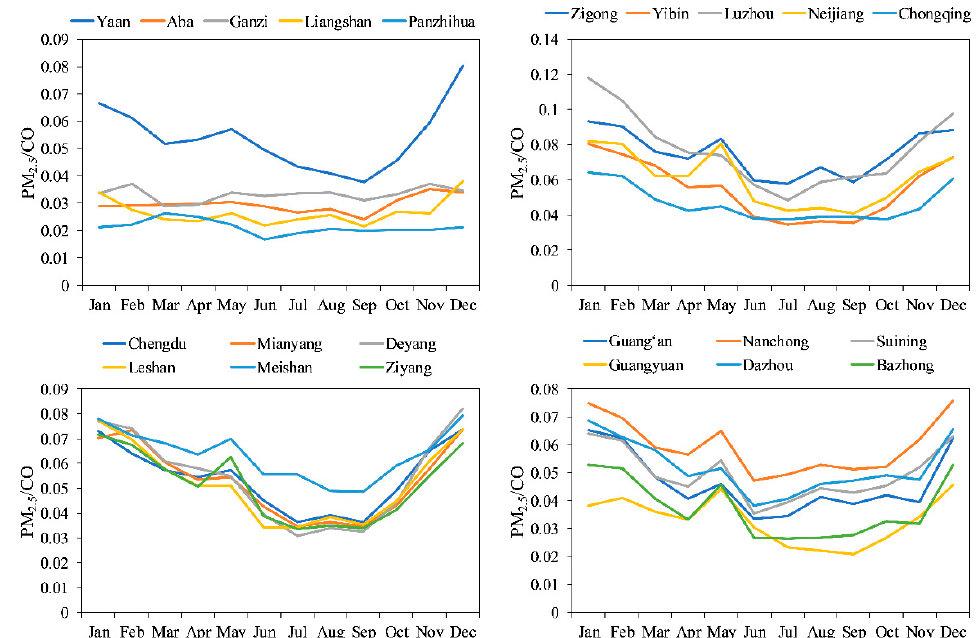
Figure 7. The monthly average PM 2.5 /CO ratio of each city.